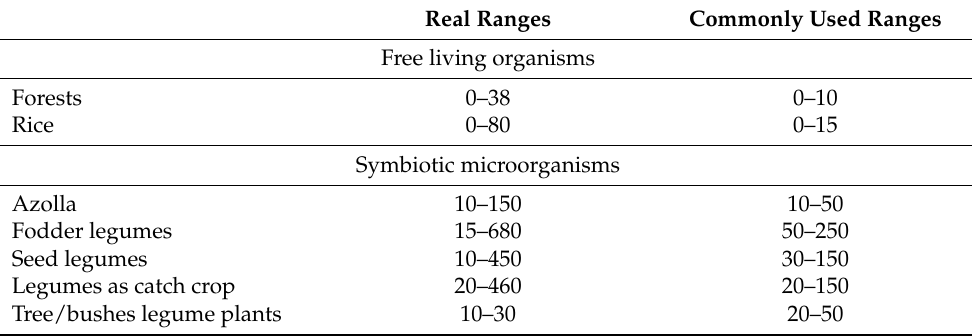
Table 2. The ranges of N fixation in various ecosystems [55], kg N ha − 1 . Real Ranges Commonly Used Ranges Free living